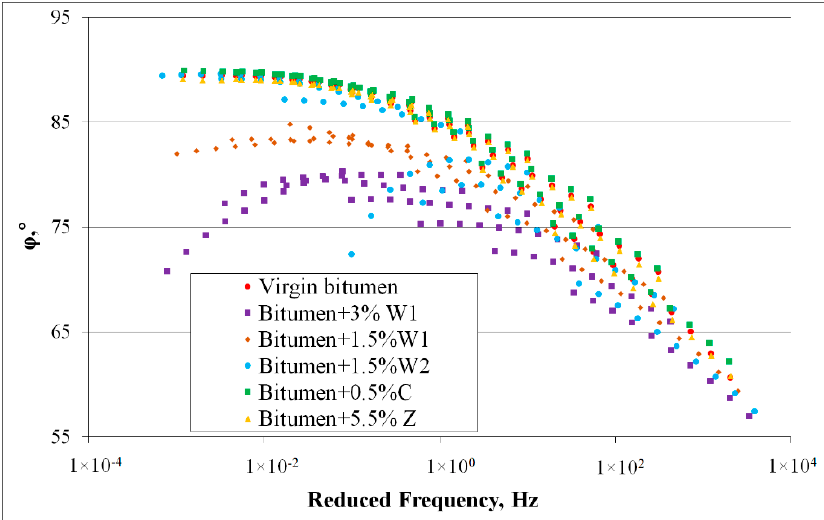
Figure 4. DSR master curves for phase angle φ of 50/70 virgin bitumen and bitumen blends con- taining additives.